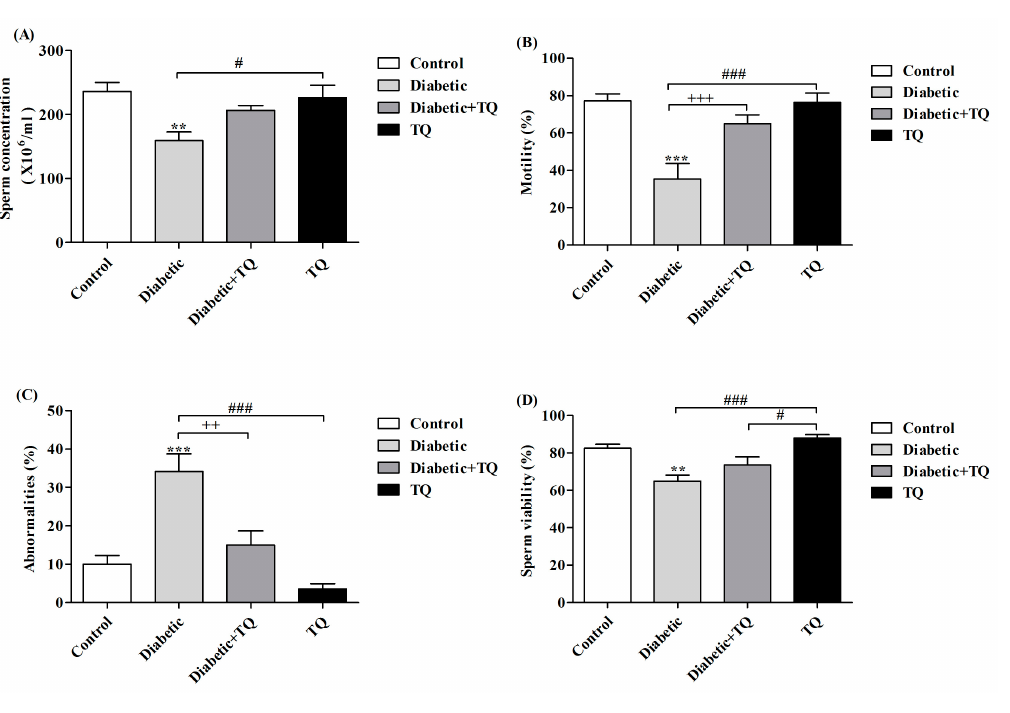
Figure 4. Sperm cell concentration ( A ), Motility % ( B ), Abnormalities ( C ), and Viability ( D ) in Control, Diabetic, Diabetic + TQ, and TQ groups. ** p < 0.01 and *** p < 0.001 vs. Control. ++ p < 0.01, +++ p < 0.001 vs. Diabetic. # p < 0.05, and ### p < 0.001 vs. TQ. TQ: thymoquinone.